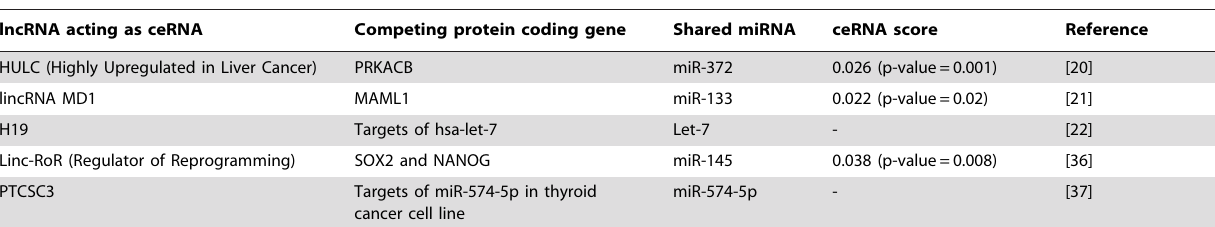
Table 1. Experimentally verified lncRNA ceRNAs in ln Ce